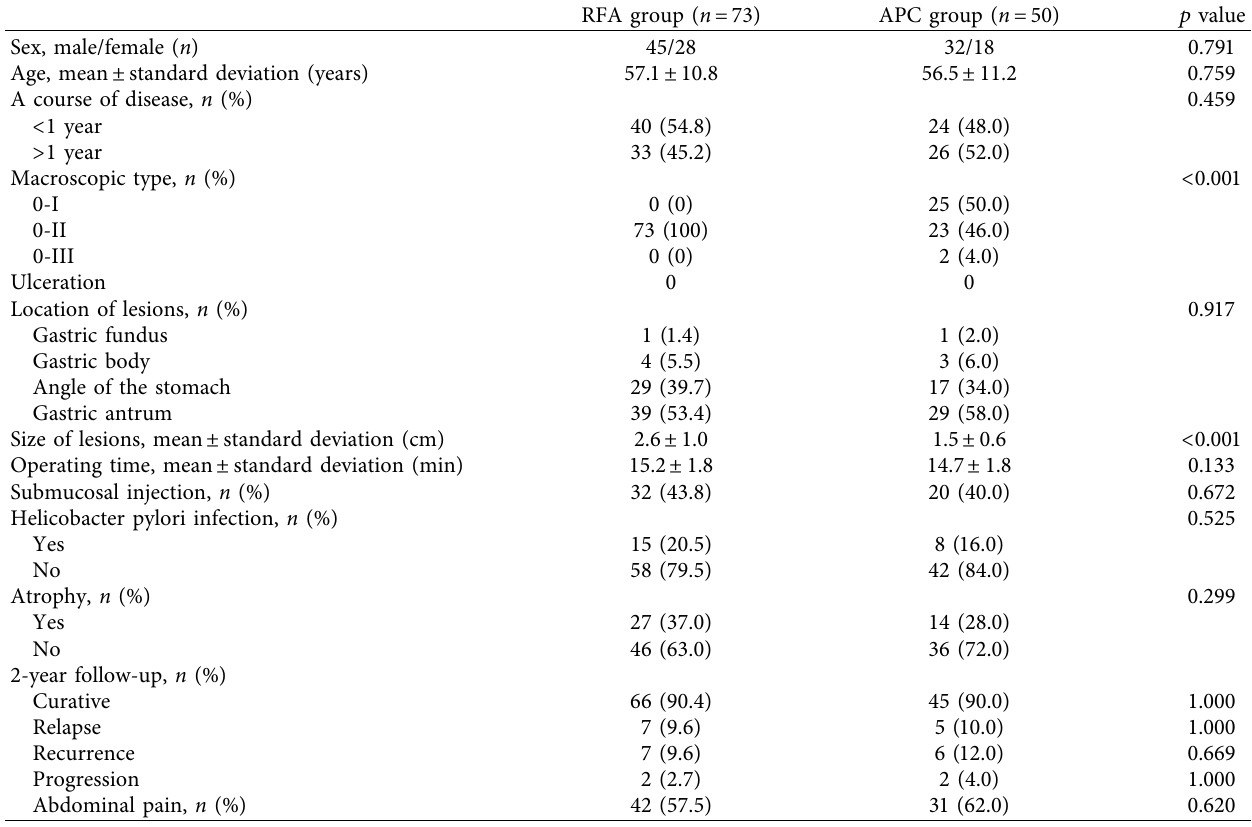
Table 1: Baseline characteristics, procedure-related parameters, and